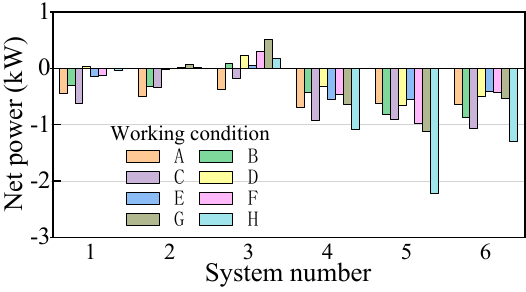
Figure 18. Net power of each system under 35 °C.